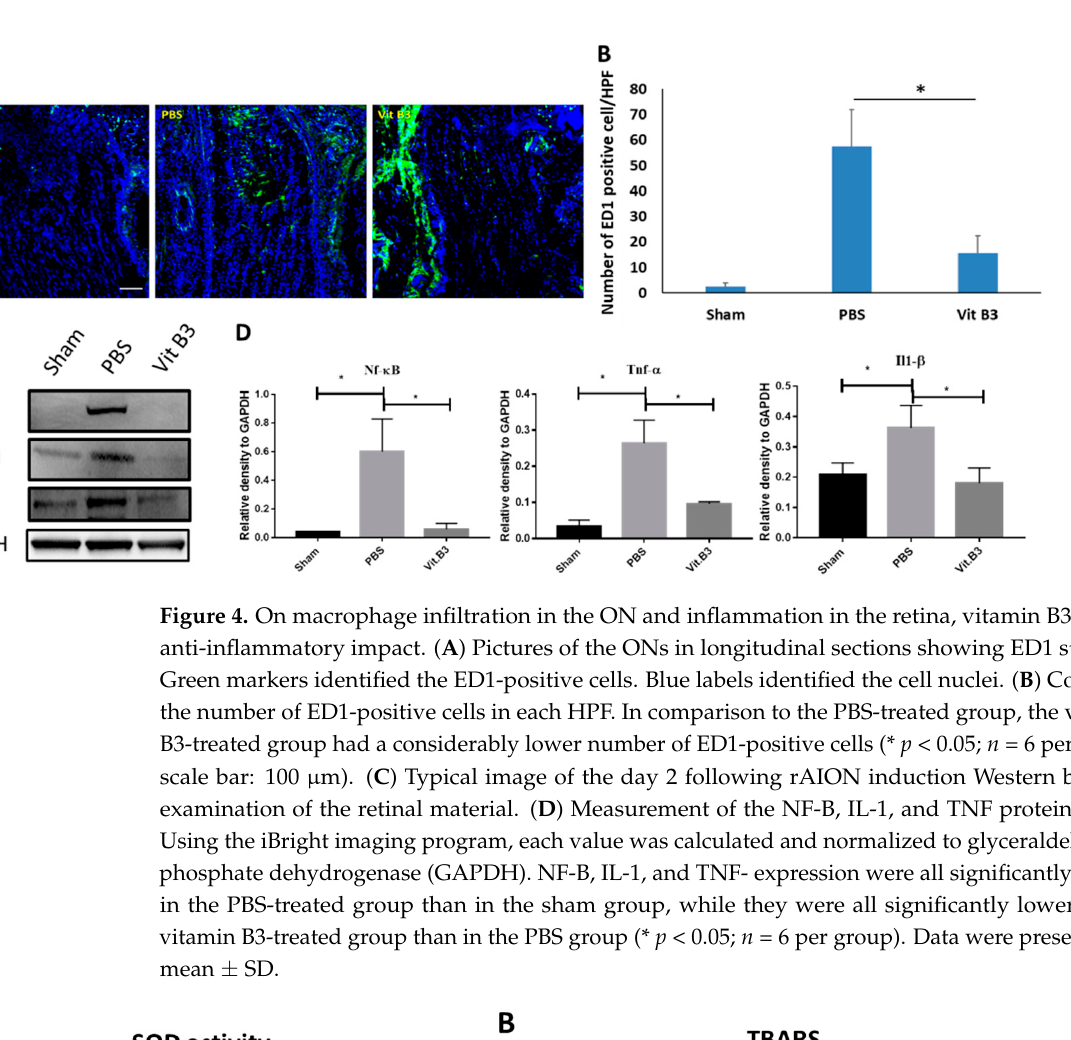
Figure 4. On macrophage infiltration in the ON and inflammation in the retina, vitamin B3 has an anti-inflammatory impact. ( A ) Pictures of the ONs in longitudinal sections showing ED1 staining. Green markers identified the ED1-positive cells. Blue labels identified the cell nuclei. ( B ) Counting the number of ED1-positive cells in each HPF. In comparison to the PBS-treated group, the vitamin B3-treated group had a considerably lower number of ED1-positive cells (* p < 0.05; n = 6 per group; scale bar: 100 μ m). ( C ) Typical image of the day 2 following rAION induction Western blotting examination of the retinal material. ( D ) Measurement of the NF-B, IL-1, and TNF protein bands. Using the iBright imaging program, each value was calculated and normalized to glyceraldehyde- 3-phosphate dehydrogenase (GAPDH). NF-B, IL-1, and TNF- expression were all significantly higher in the PBS-treated group than in the sham group, while they were all significantly lower in the vitamin B3-treated group than in the PBS group (* p < 0.05; n = 6 per group). Data were presented as mean ± SD.